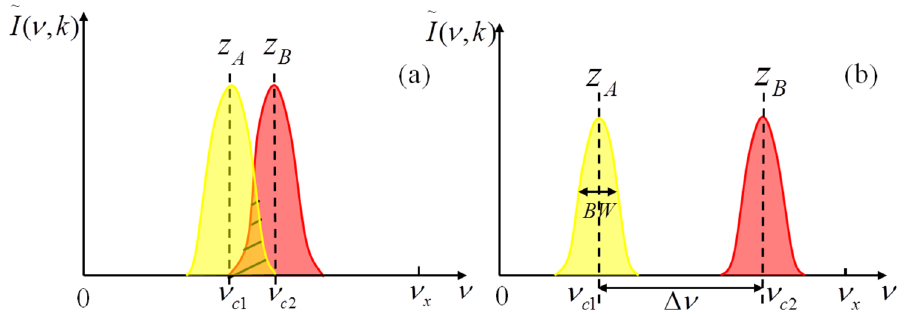
Figure 4. Schematic of the choice of the center spatial carrier frequencies. Crosstalk between the spatial spectra occurs in ( a ), and the two spatial spectra can be well separated through parameters design as shown in ( b ).